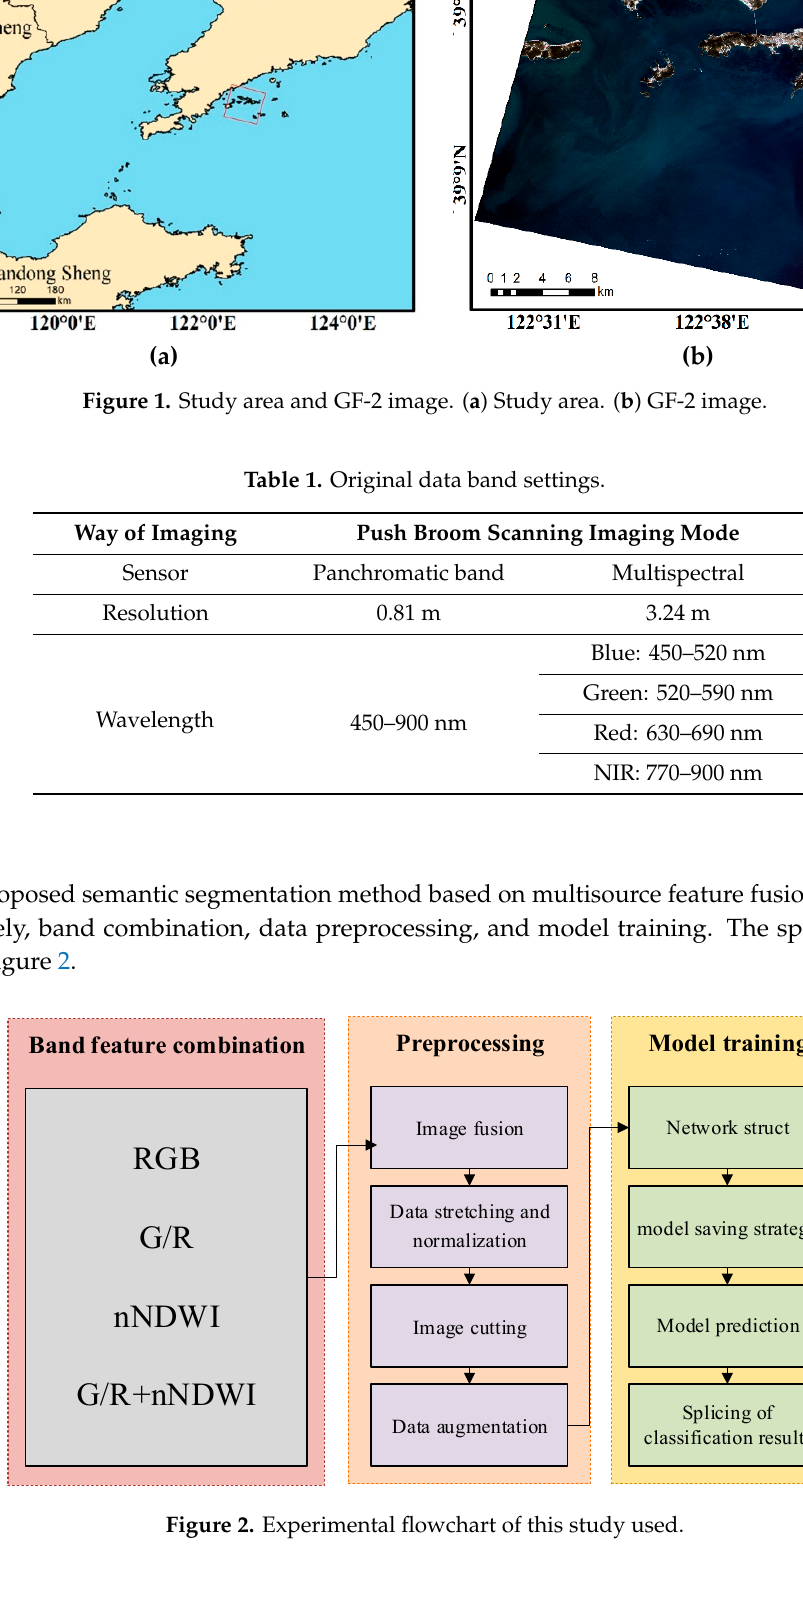
Figure 2. Experimental flowchart of this study used.